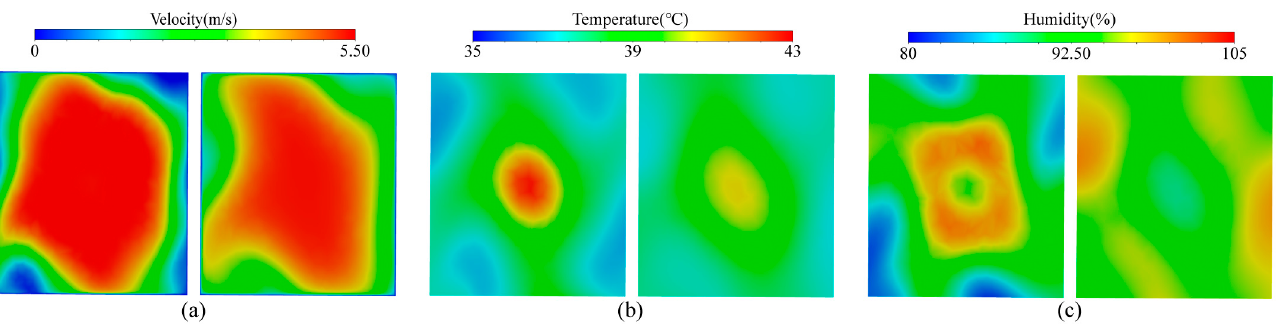
Figure 4. Cloud picture of wind velocity, temperature, and humidity in monitoring surfaces A (left) and B (right). ( a ) Wind velocity cloud picture; ( b ) temperature cloud picture; ( c ) humidity cloud picture.